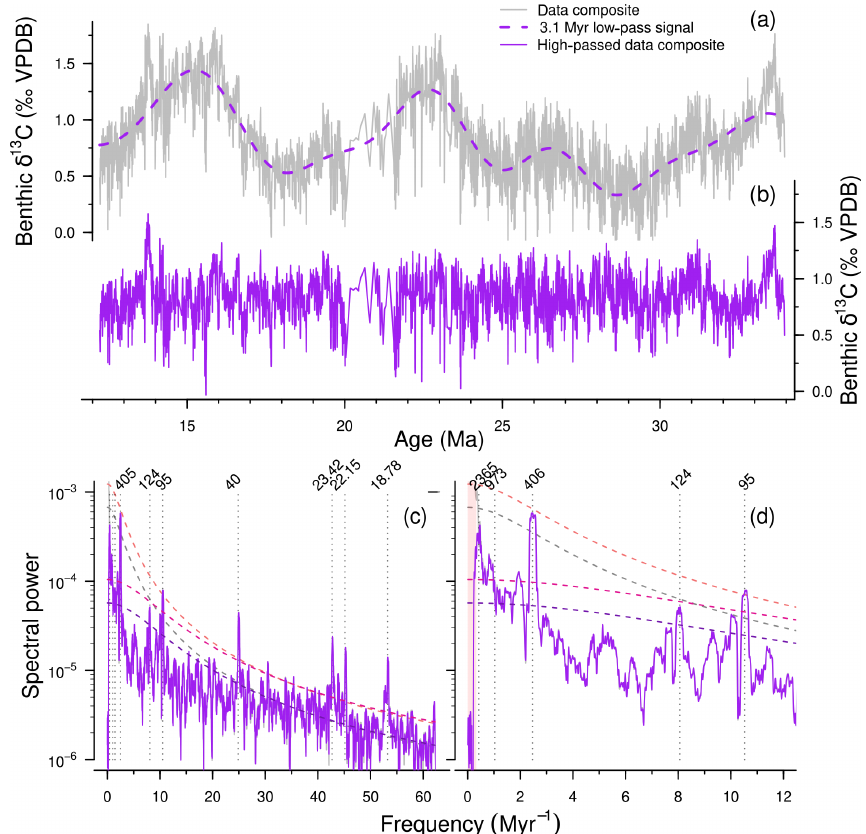
Figure 5. (a) δ 13 C composite record (grey line) with a low-pass filter for frequencies below 3.1Myr (dashed purple line). (b) The adjusted composite (purple) in the time domain. (c) The same records in the frequency domain. Dashed smooth lines represent the AR-1 fits for the δ 13 C and detrended δ 13 C records (grey and purple respectively) with associated 95% confidence intervals (light and dark red respectively). Main orbital periods (kyr) are labelled and marked with dotted lines. (d) A zoomed-in version of (c) on the frequency axis, with the red shaded region indicating the range of the low-pass